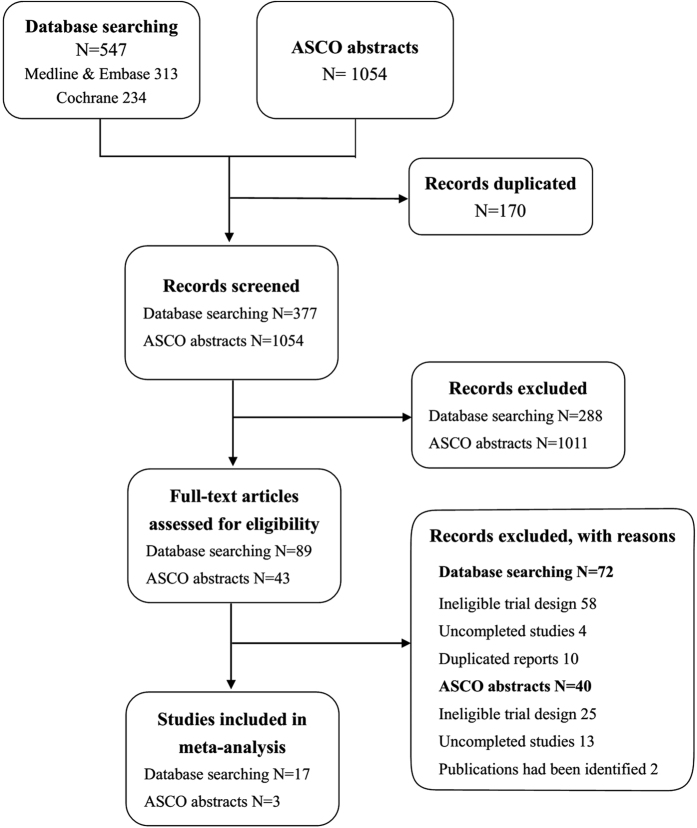
Study flow diagram.